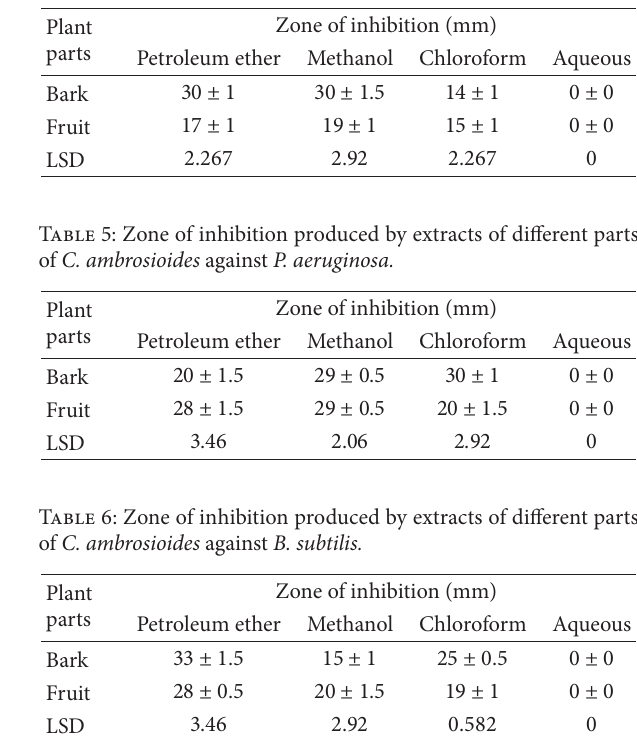
Table 2: Zone of inhibition (mm) of fungal strains against the standard antifungal discs.